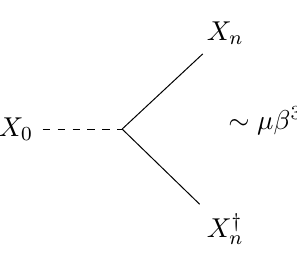
Figure 1 . A possible Feynman diagram for the interaction